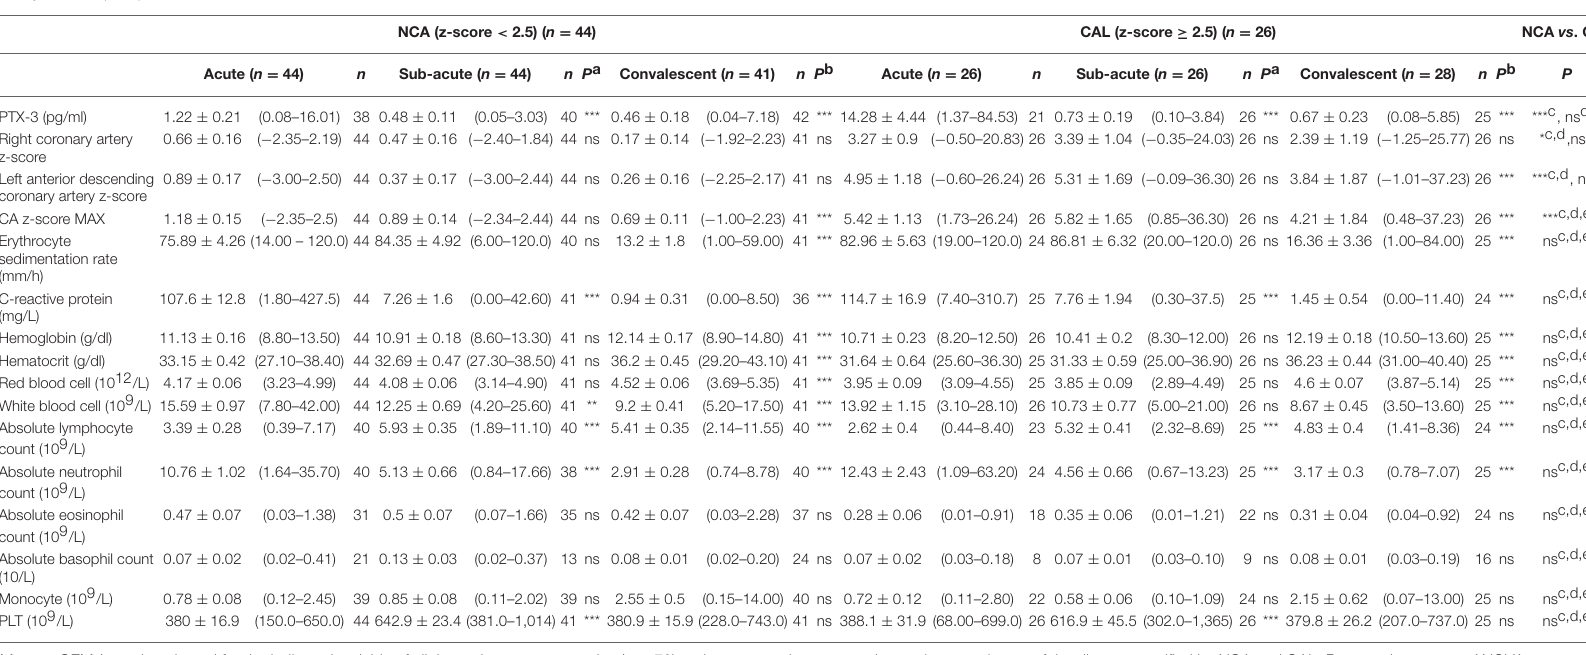
Mean ± SEM (range) evaluated for the indicated variable of all the patient serum samples (n = 70) at the acute, sub-acute, and convalescent phases of the disease stratified by NCA and CAL. Repeated-measures ANOVA was used to compare the coronary artery z-scores and the clinical laboratory parameters between the three phases of KD. p-value comparing the effect of the variable at each phase. a p-value between acute and sub-acute phases. b p-value between acute and convalescent phases. c p-value comparing the acute NCA and the acute coronary artery lesion groups. d p-value comparing the sub-acute NCA and the sub-acute coronary artery lesion groups. e p-value comparing the convalescent NCA and the convalescent coronary artery lesion groups. *** p ≤ 0.001; ** p ≤ 0.01; * p ≤ 0.05. SEM, standard error mean; CA, coronary artery; CA z-score MAX, largest coronary artery diameter between the right coronary artery and the left anterior descending coronary artery z-scores; ns, not significant (p >